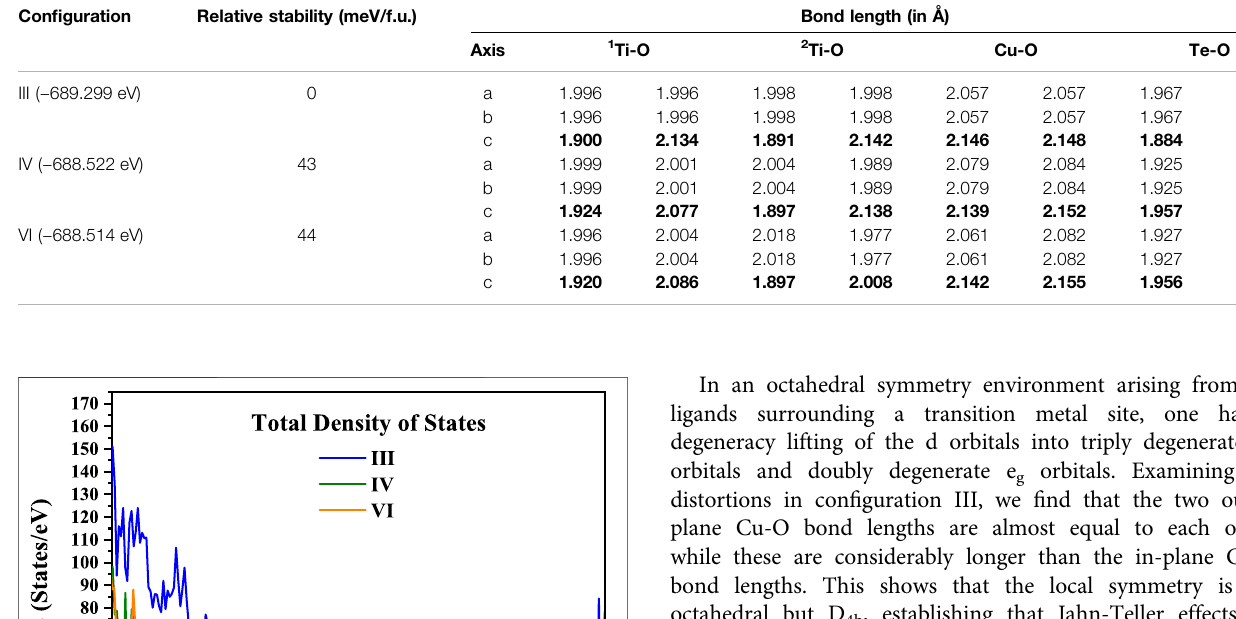
TABLE 2 | Energies and metal oxygen bond lengths in the MO 6 octahedra for geometry optimized DFT + U (U (cid:2) 6) calculations for the three con fi gurations III, IV and VI of BaTi 1-x (Cu 1/2 Te 1/2 ) x O 3 with x (cid:2) 0.11. The axes having the largest off centering distortion in Ti-O bond lengths have been highlighted in bold. Con fi guration Relative stability (meV/f.u.)